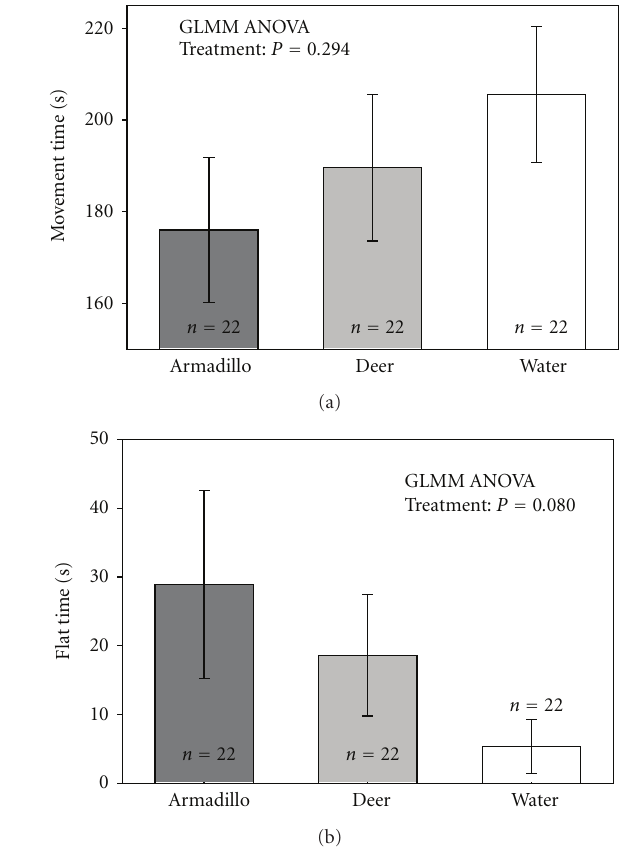
Figure 3: Experiment 1: behavioral responses to substrate cues. Time spent moving (a) and time spent on the edge of the arena (b) for salamanders exposed to stimuli from armadillos, deer, or blank control water. Bars and error bars represent means ± 1 SE. Asterisks indicate statistical significance.